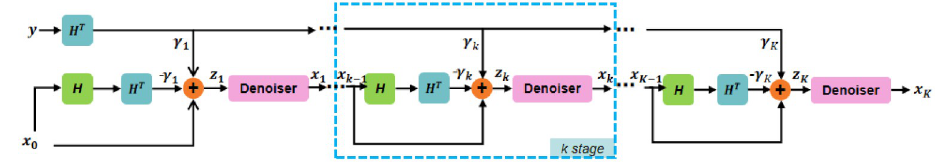
Fig 1. Framework of proposed iterative deep neural